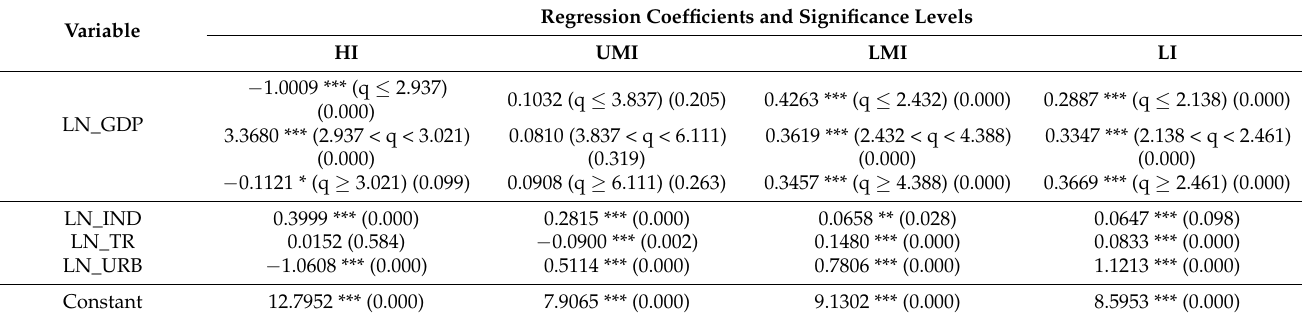
Table 8. Regression results of the economy on ecological footprint of the threshold model in different income